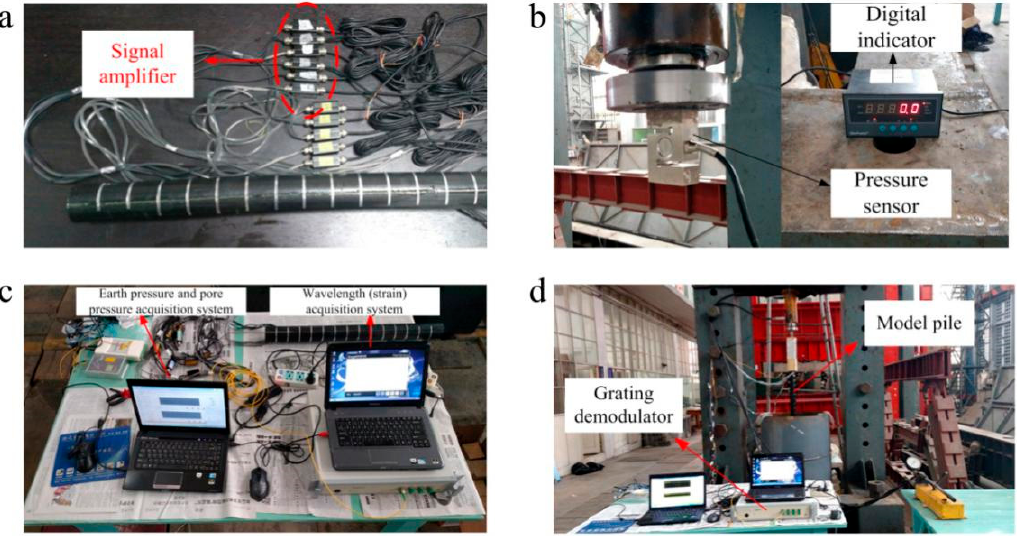
Figure 8. Photographs showing the testing process: ( a ) Marked model pile and sensors. ( b ) Pressure sensors and matching digital display. ( c ) Connected instruments and equipment. ( d ) Testing and data collection.